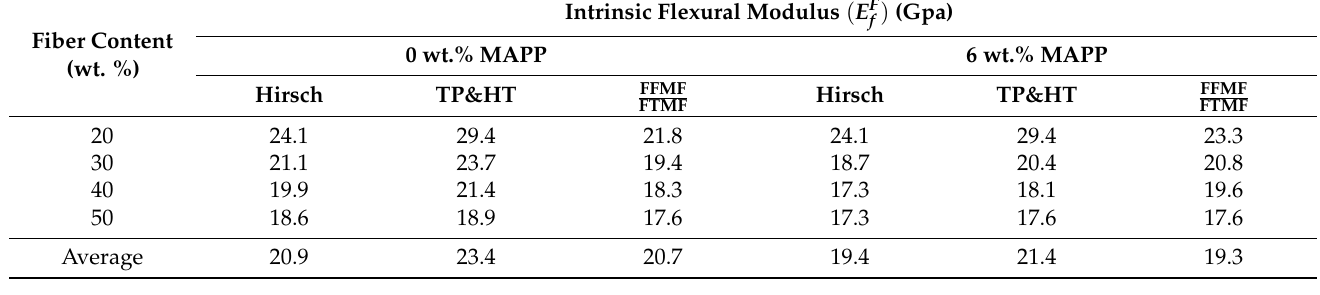
Table 4. Intrinsic flexural modulus of cotton fibers obtained using (i) Hirsch model, (ii) Tsai–Pagano model using Halpin–Tsai equation (TP&HT) (iii), and the ratio between the FFMF and FTMF.